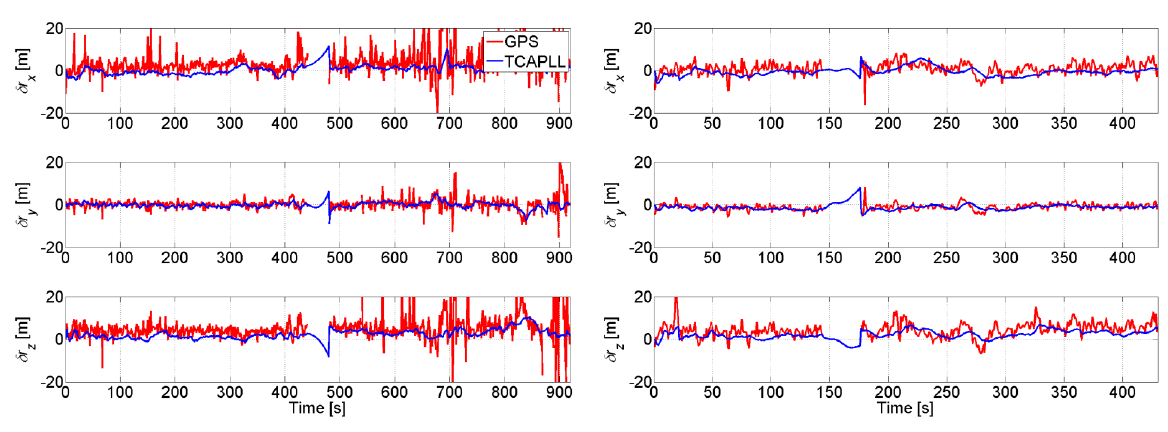
Figure 29. Position error during Trajectory 1 ( left ) and Trajectory 2 ( right ).